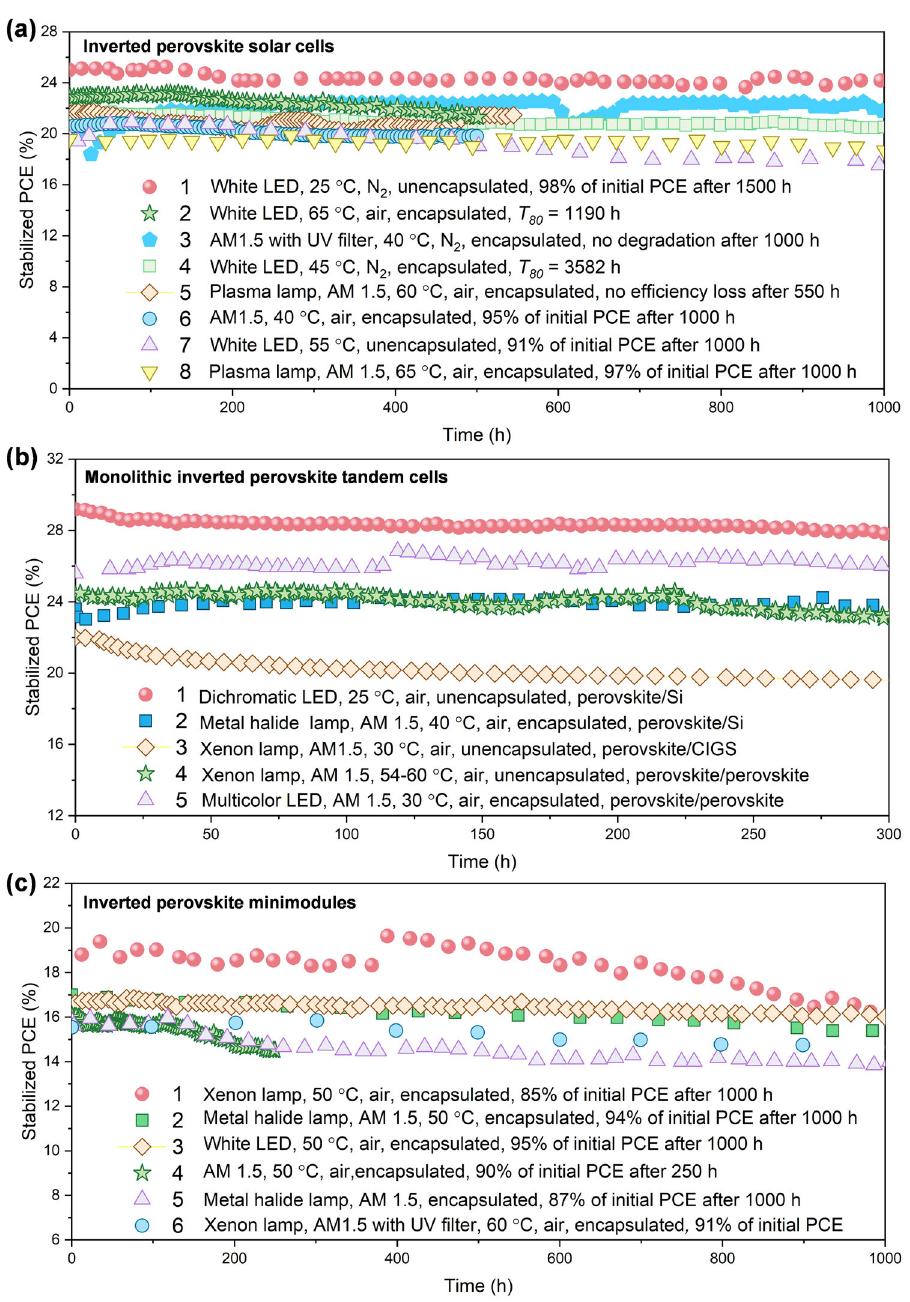
Fig. 4 The summary of operational stability of IPSCs based on MPPT results. a Small-area single-junction cells. b Tandem cells. c Minimodules. Note that all these devices are based on rigid substrates. The initial ef fi ciency of sample 1 in ( a ) is unclear so we use the claimed champion PCE of 25% for reference. For each point, the data were extracted from the representative works (see details in Table 3). LED denotes light-emitting diode. AM 1.5 indicates air mass 1.5. T 80 denotes the lifetime at 80% of the initial ef fi